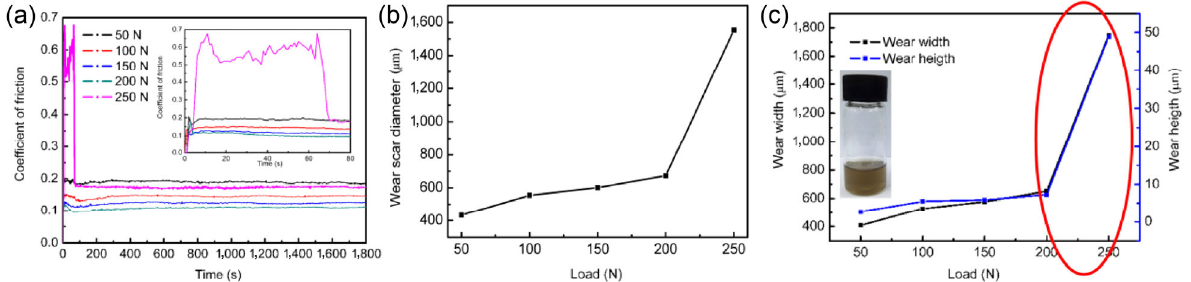
Fig. 17 Friction properties of GO-16C at various loads: (a) COF of GO-16C at various loads; (b) wear width and wear height of lower samples (disc).